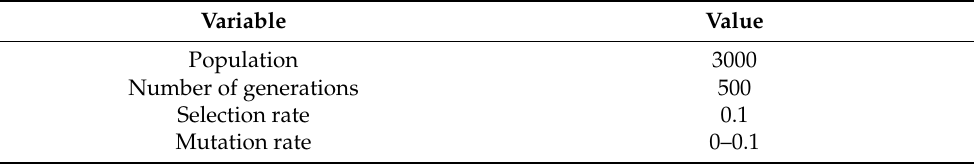
Table 2. The input values in the GA [22].